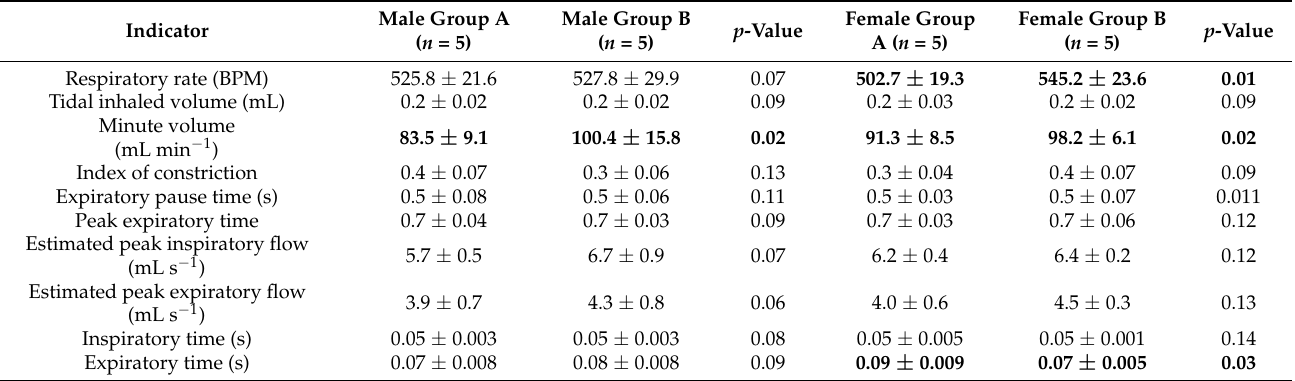
Table 1. The summary data (mean ± standard deviation) on indicators of respiratory function in mice exposed to ambient air with and without HEPA filter from 31 March 31 to 2 April 2018 (air polluted